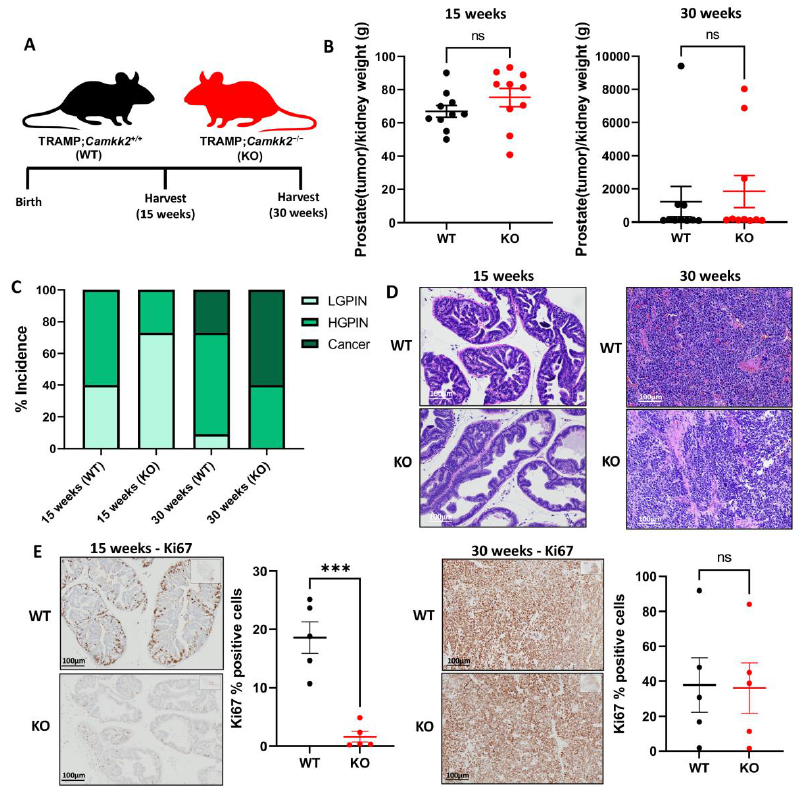
Figure 1. Camkk2 knockout impairs PIN development at 15 weeks, but disease relapse occurs by 30 weeks in C57BL/6 TRAMP mice. ( A ) Schema for mouse experiment. ( B ) Prostate (plus localized cancer if present) weight normalized to kidney weight for 15 weeks (left) (WT n = 10, KO n = 10) and 30 weeks (right) (WT n = 10, KO n = 10). ( C ) % low-grade PIN (LGPIN), high-grade PIN (HGPIN), and cancer incidence among cohorts. ( D ) Representative images of prostates and tumors. ( E ) Ki67 staining of tumors at 15 weeks (left) and 30 weeks (right). *** p < 0.001; ns = not significant by t -test.